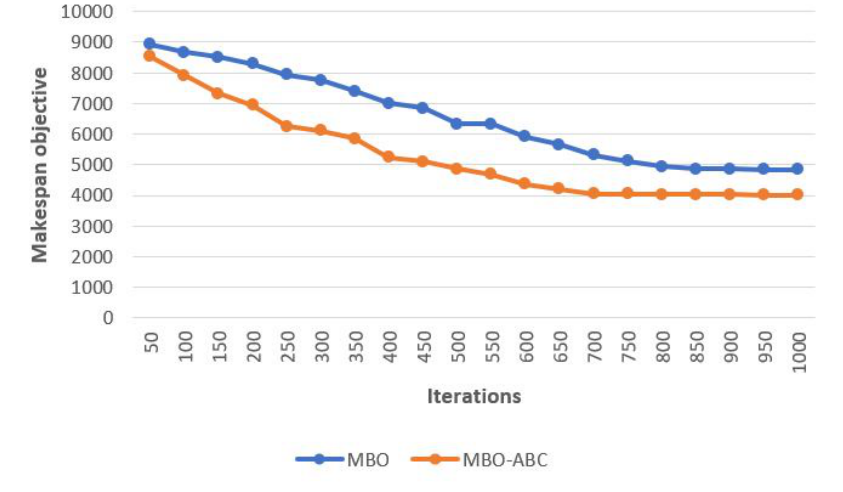
Figure 14. MBO-ABC vs. MBO convergence speed for the problem instance with 2000